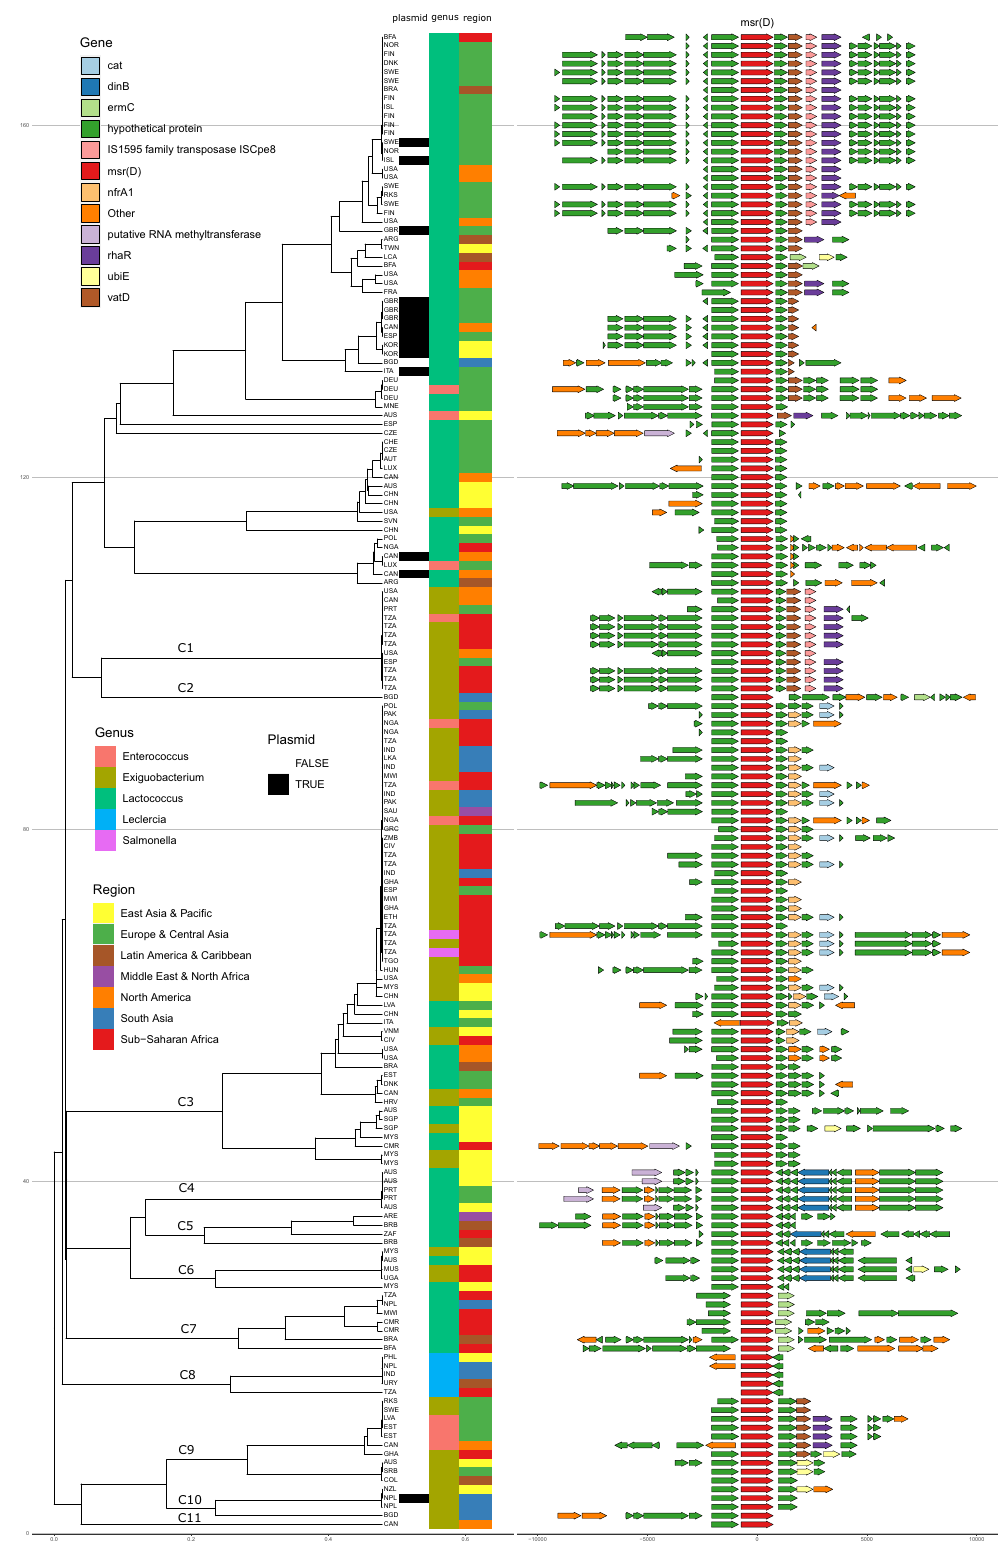
Fig.5|ARGFlanksshowdiversegenomiccontexts. Flankingsequencefor msr (D) variantsinthesewagewereusedtocalculateakmerdistanceUPGMAtree.Thetree shows contig-level annotation: plasmid annotation status, predicted genera and WorldBankregion.ForARGsyntenyanalyses,allvariantsoftheARGwereoriented